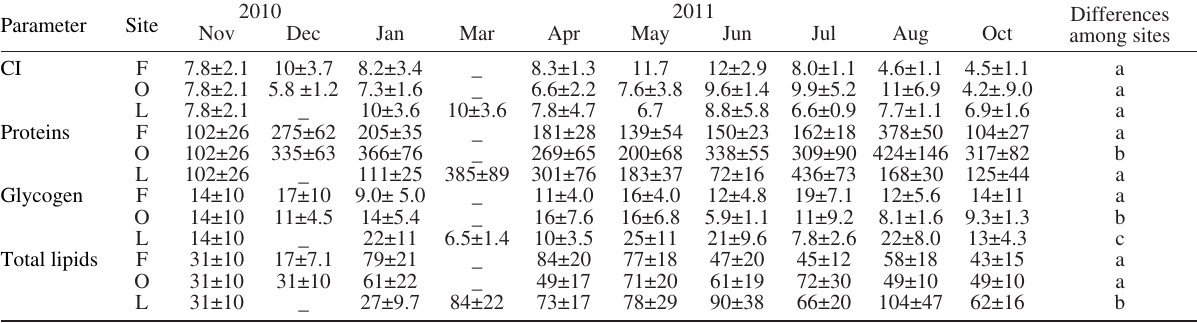
Table 3. – Mean values (±SD; n=10) of condition index (CI), proteins, glycogen and total lipids (μg mg –1 dw) of Ruditapes decussatus col- lected at sites F, O and L in November, December 2010, January, March, April, May, June, July, August and October 2011; different letters (a, b, c) correspond to significant (p<0.05) differences among sites, considering all sampling dates.